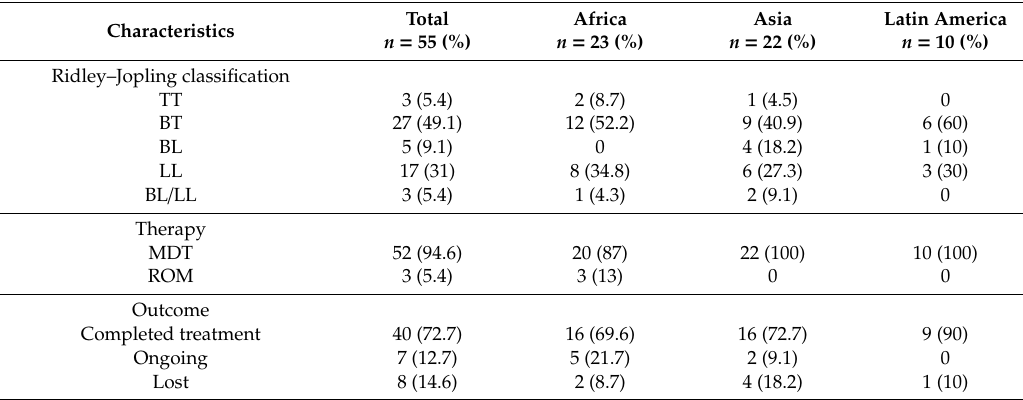
Figure 3. Hypotrophy of the hypothenar region with the flexion of the fifth proximal interphalangeal joint in a 37-years old migrant from Senegal with a diagnosis of tuberculoid leprosy. An edema of the face (Figure 4a,b) or extremities was observed in four patients, an ocular involvement in three, while fever, arthritis, and lymphadenopathy were observed in two patients each.